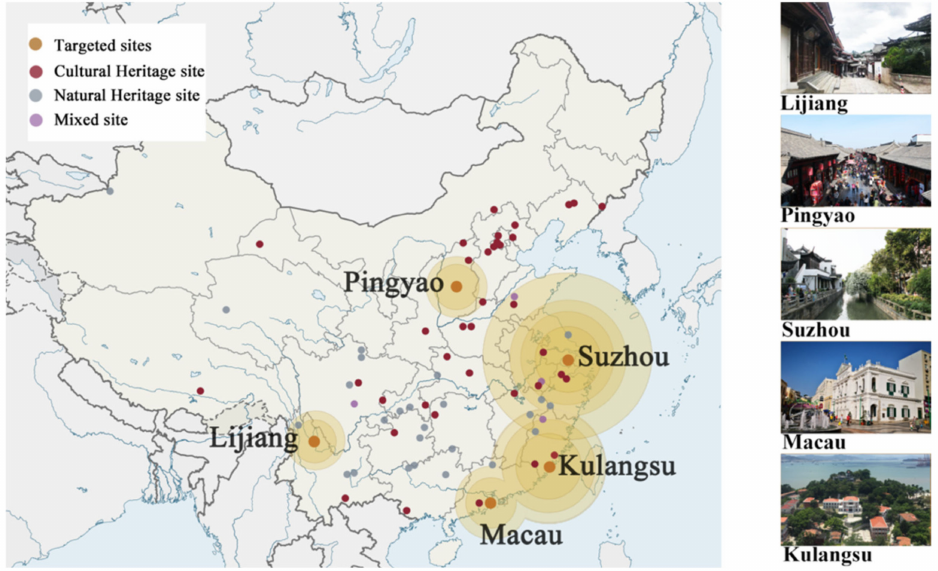
Figure 2. Geographical Distribution of China’s Urban Heritage and Other World Heritage Sites (the author draws according to the UNESCO World Heritage List